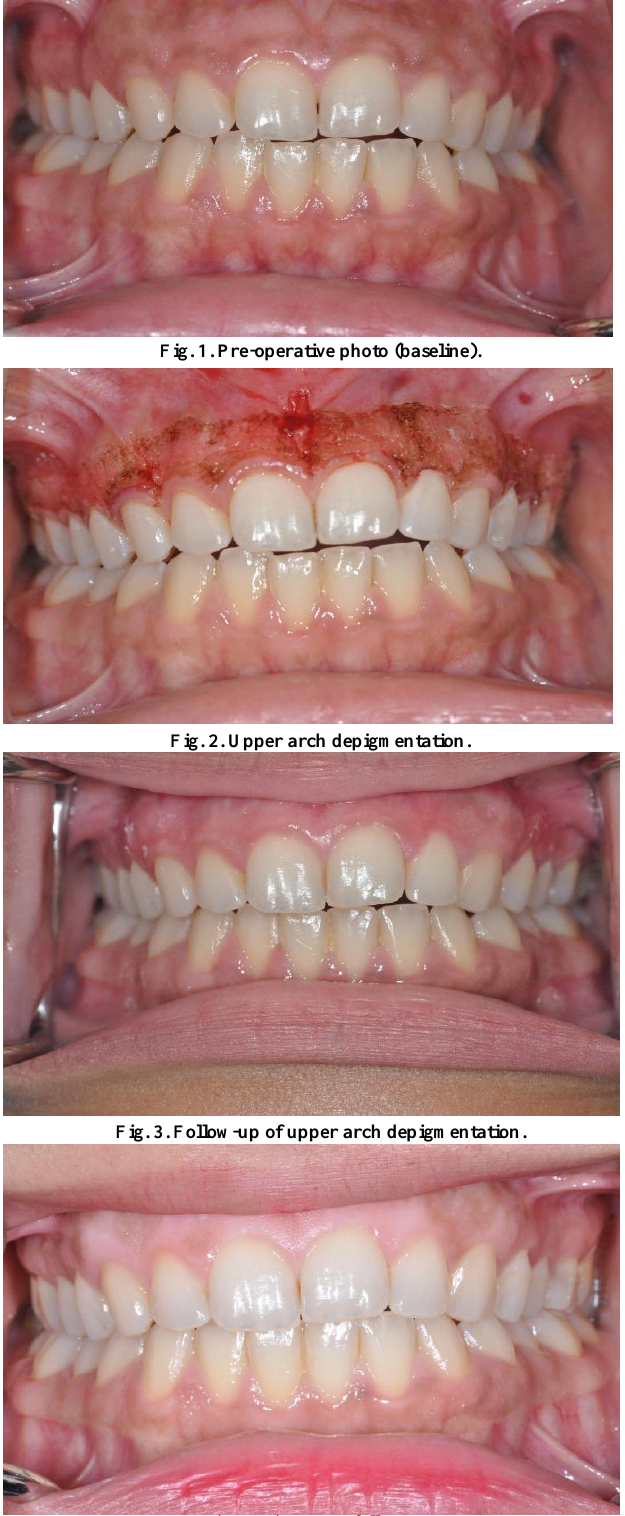
Fig. 4. Five years